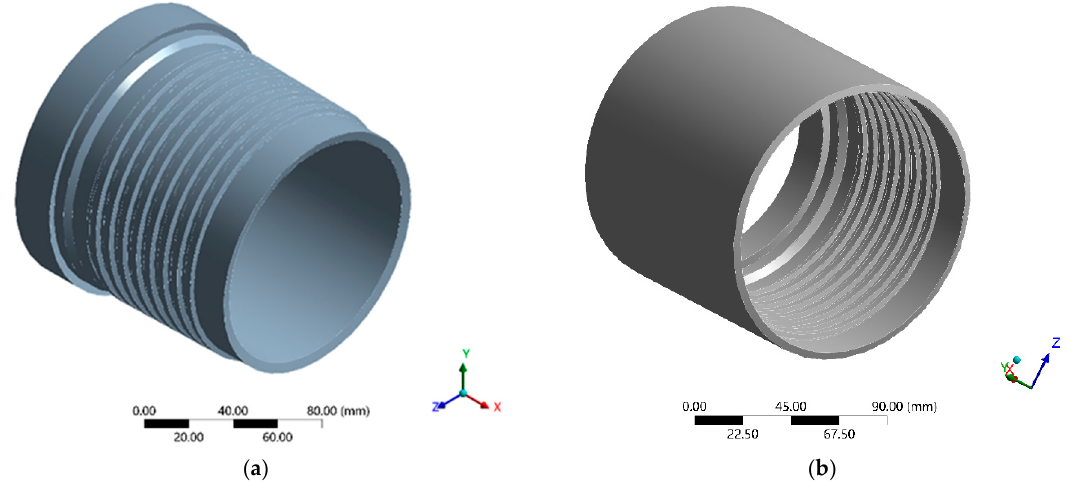
Figure 3. Three-dimensional models of the ( a ) pin joint and ( b ) box joint.